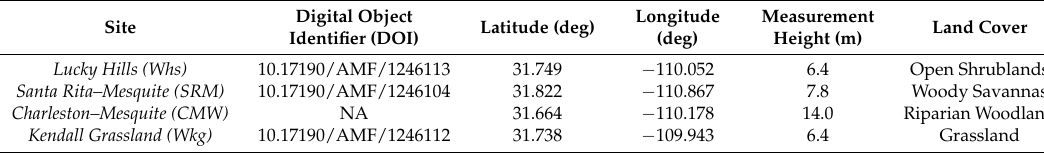
Table 1. Details of eddy covariance tower validation sites used in this study.